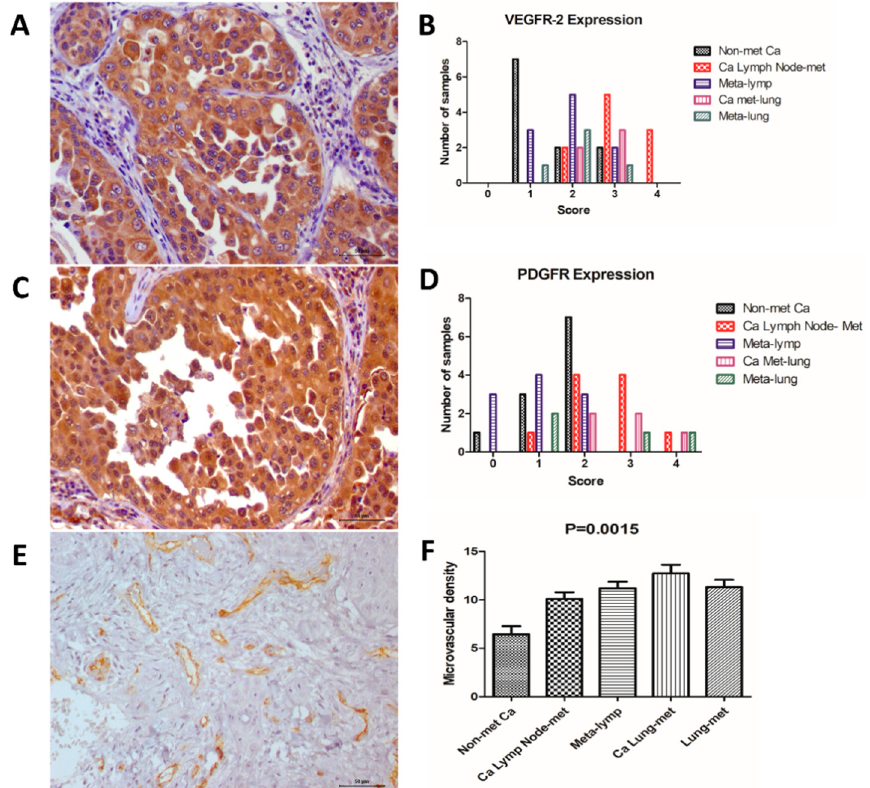
Figure 3. Immunoexpression of the different markers. ( A ) Vascular endothelial growth factor receptor 2 (VEGFR-2) (score 4) expression in a mammary carcinoma with lymph node metastasis. ( B ) Graphic representation of each immunohistochemical score for VEGFR-2 expression in all tumor groups. ( C ) Platelet-derived growth factor receptor (PDGFR) expression in a mammary carcinoma (score 2) with lymph node metastasis. ( D ) Graphic representation of each immunohistochemical score for PDGFR expression in all tumor groups. ( E ) Microvascular density (MVD) in a mammary carcinoma with lymph node metastasis. ( F ) Graphic representation of MVD, indicating an increased number of vessels in metastatic tumors.